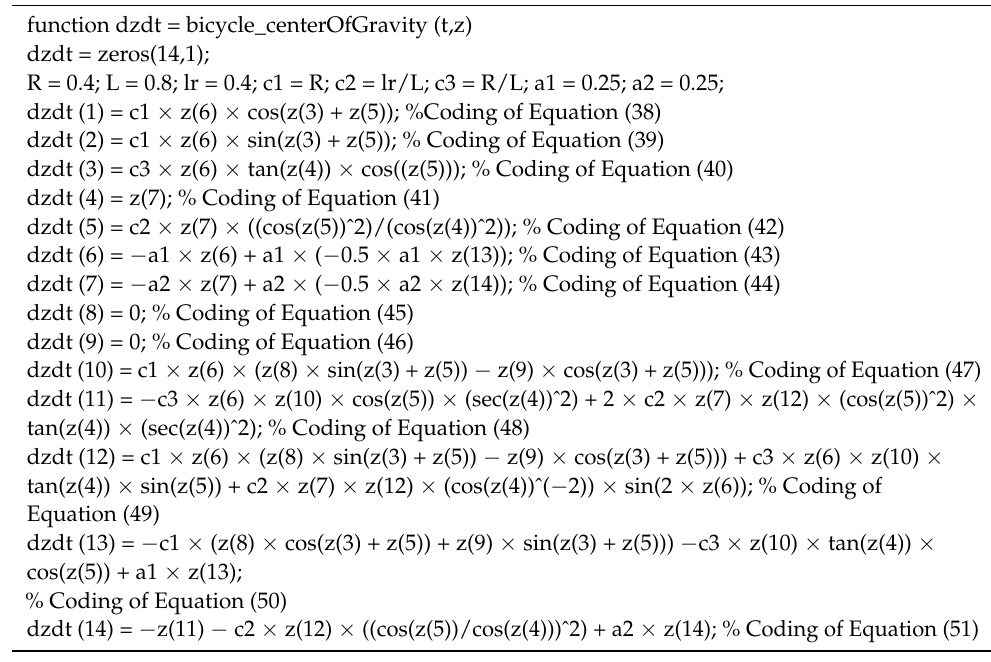
Algorithm 2 The combined state–costate system of ordinary differential equations